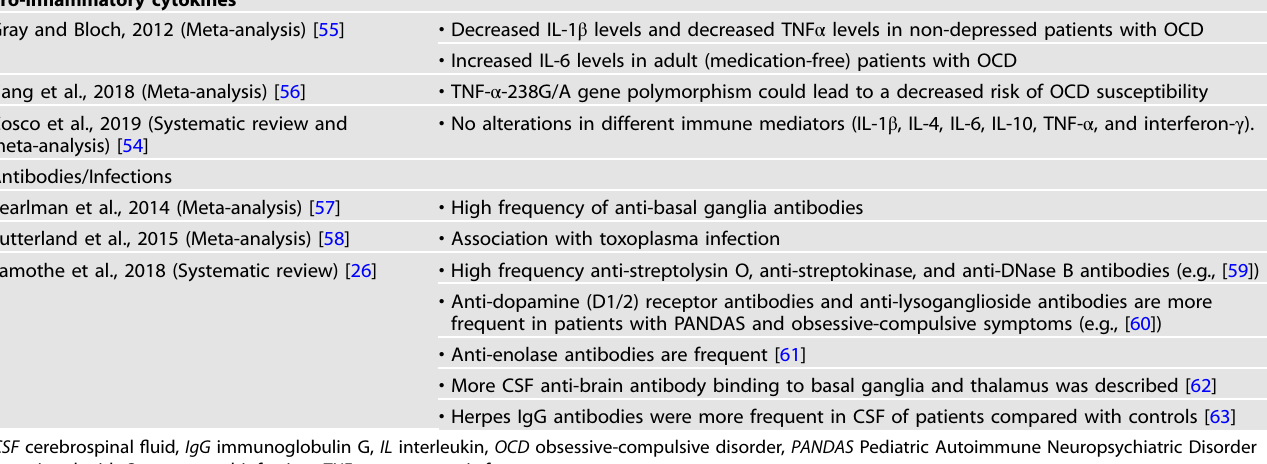
Table 1. Evidence of immunological causes in patient cohorts with assumed primary forms of obsessive-compulsive disorders (extracted from [26]). Pro-in fl ammatory cytokines Gray and Bloch, 2012 (Meta-analysis)